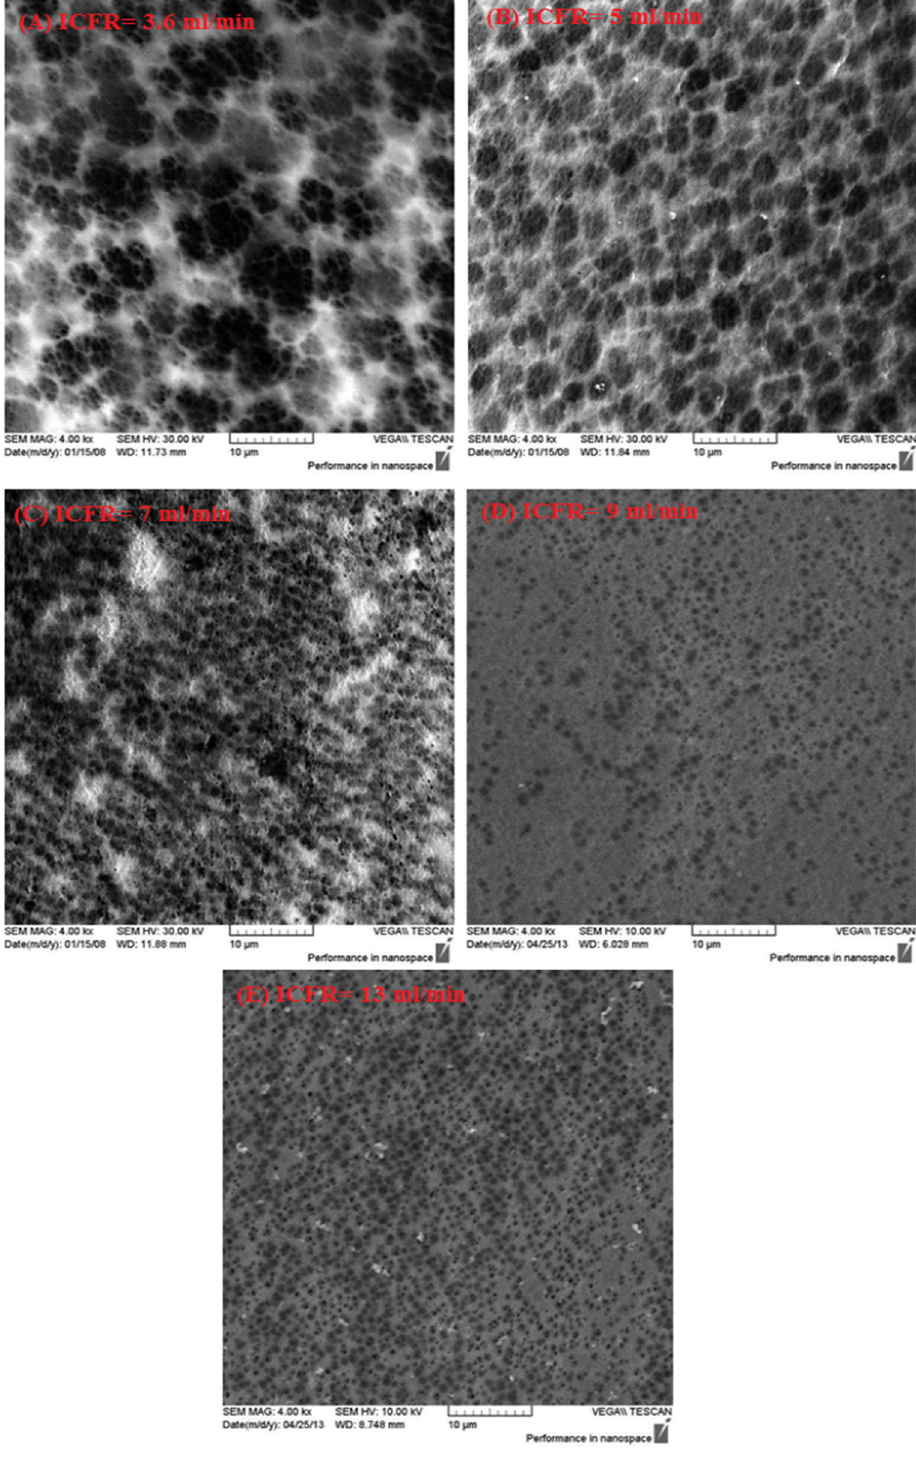
Fig. 3 SEM images of the inner surfaces of the PVC hollow fiber membranes at various